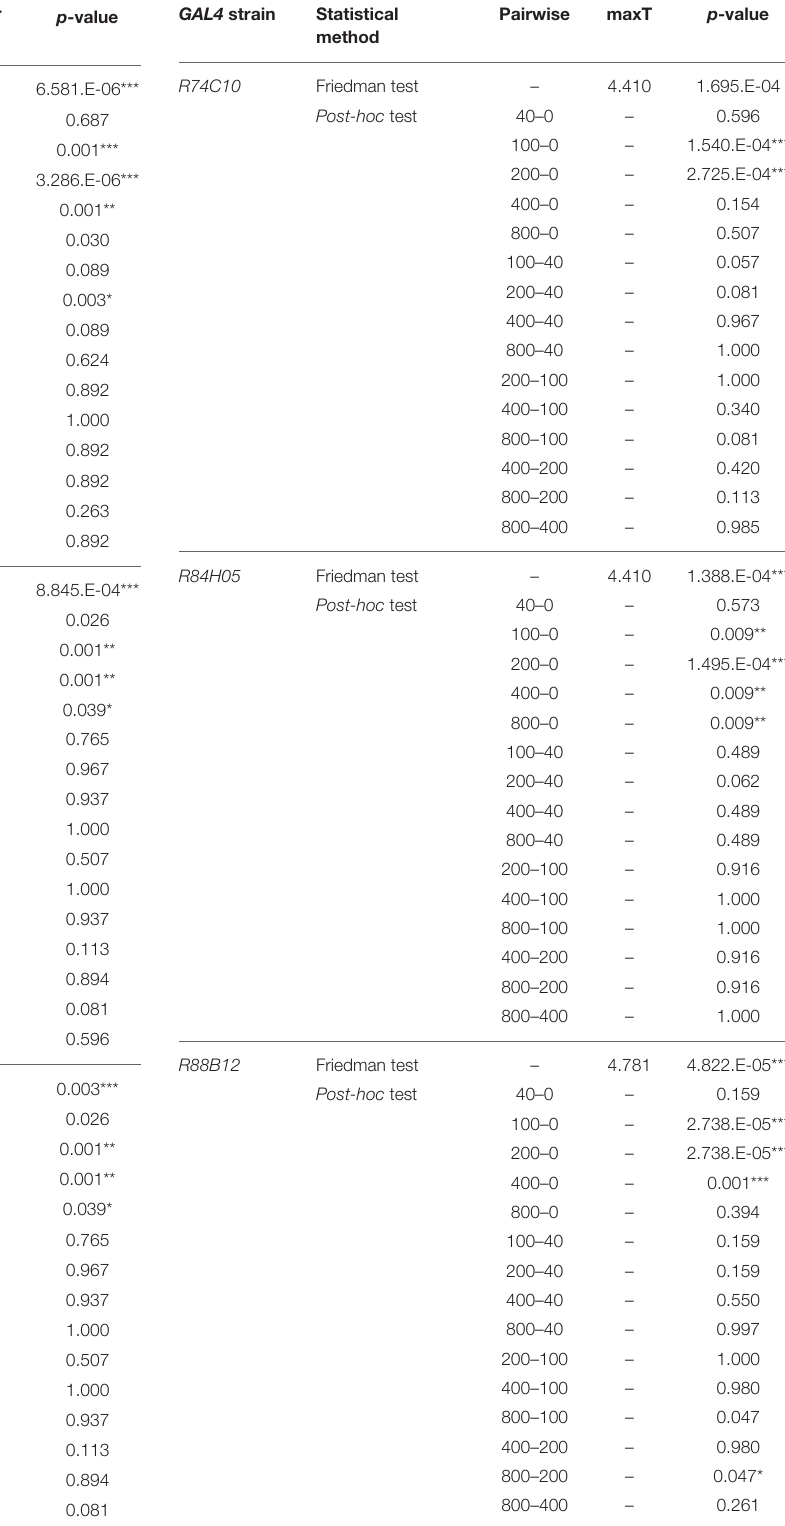
TABLE 5 | Statistical comparison of Ca 2 + responses among sinusoidal